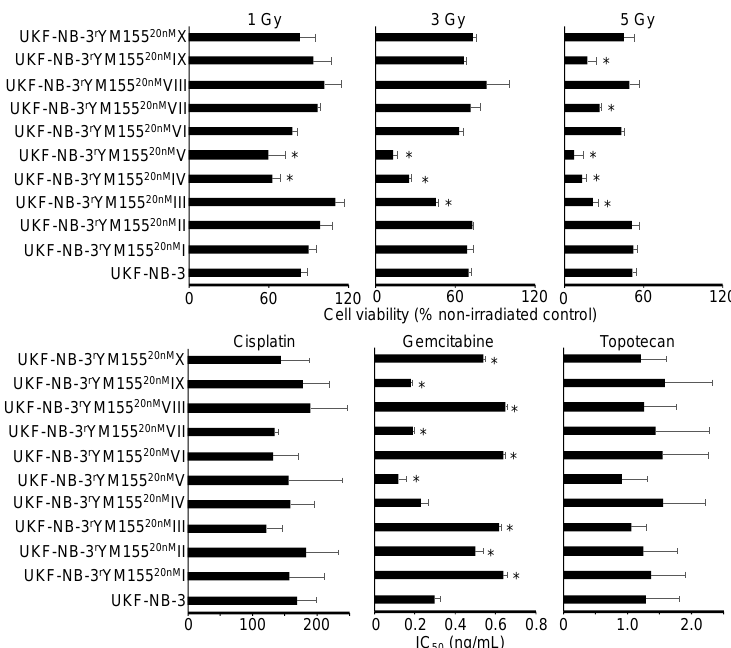
Figure 8. Sensitivity of UKF-NB-3 and its YM155-adapted sublines to irradiation and DNA-damaging drugs. The radiation response was determined 72 h after irradiation with 1, 3, or 5Gy by MTT assay. Drug concentrations that reduce cell viability by 50% (IC 50 ) were determined by MTT assay after 120 h of incubation. The YM155-adapted sublines did not display increased resistance to DNA damage induced by radiation or the drugs cisplatin, gemcitabine, or topotecan. * p < 0.05 relative to UKF-NB- 3.